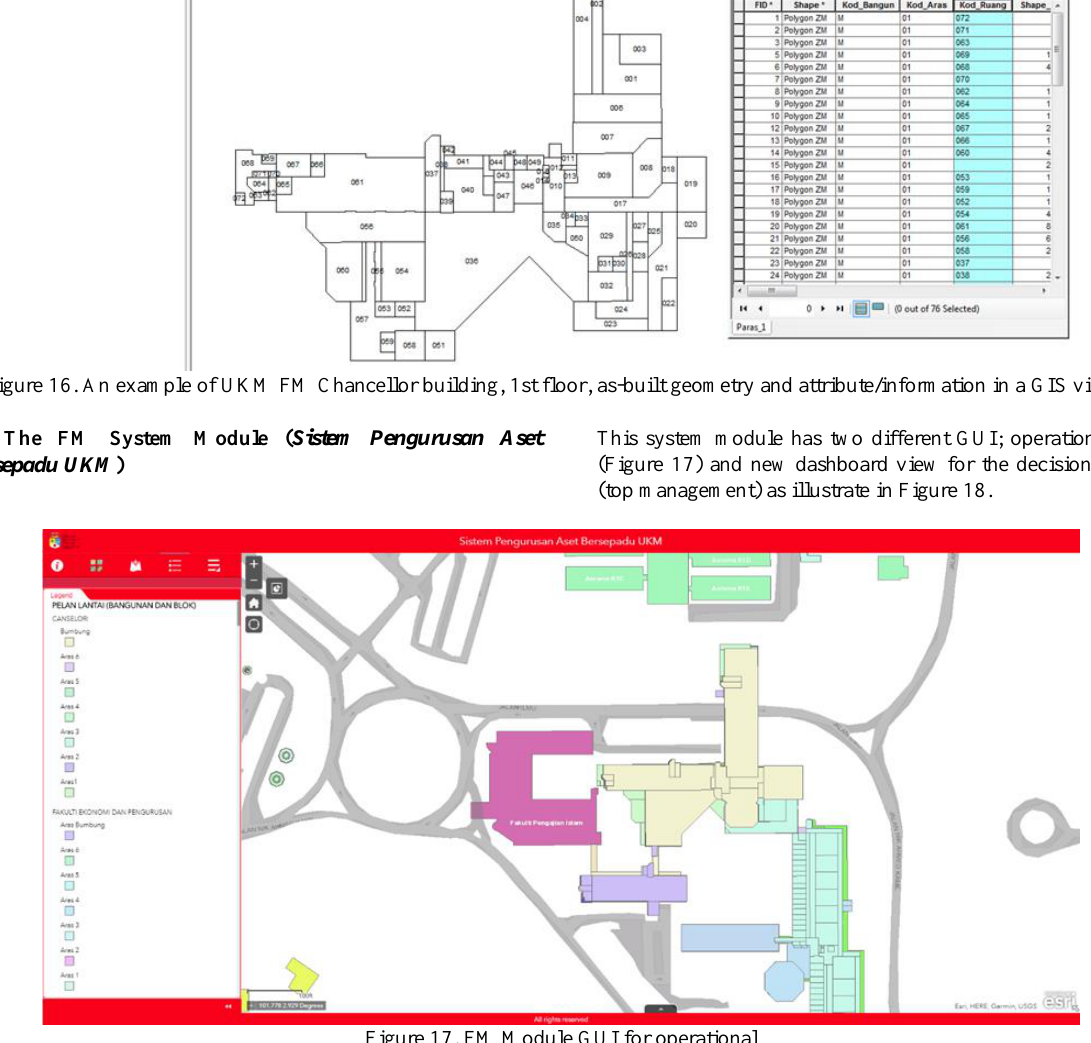
Figure 17. FM Module GUI for operational